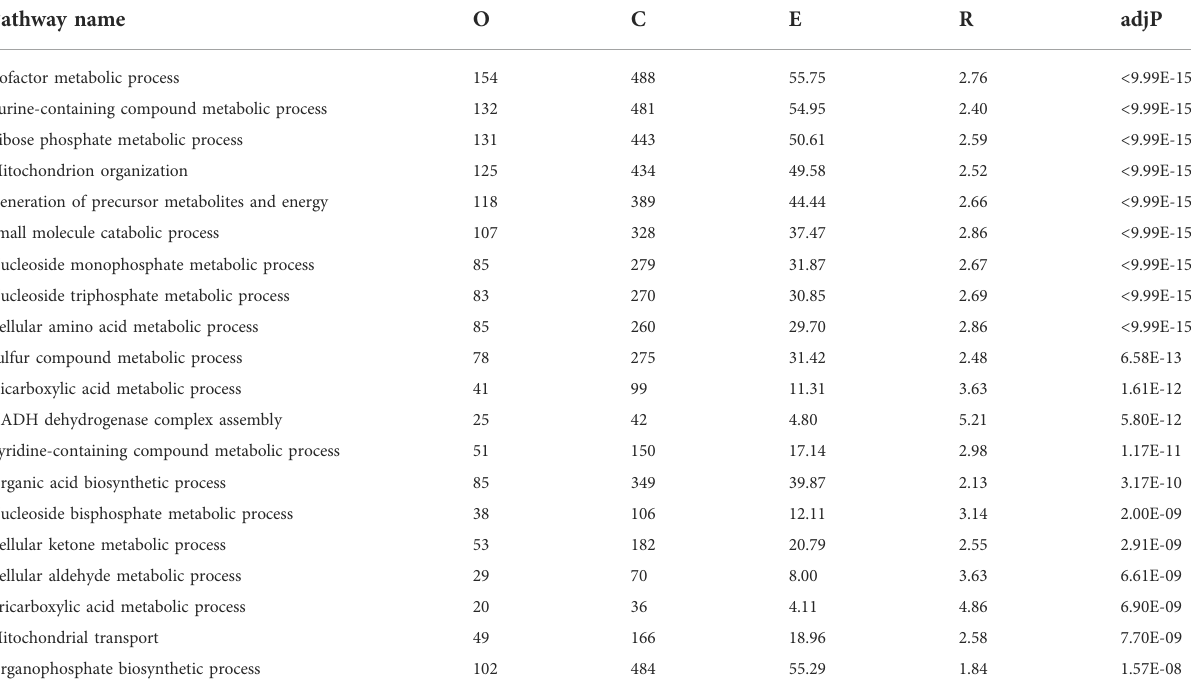
TABLE 1 Functional enrichment of negatively regulated genes annexin A1 de fi cient mice compared to wildtype mice at d10 of experimental crescentic GN. Regulated gene products corresponding to the individual in pathways are listed in Supplementary Table S2. Pathway